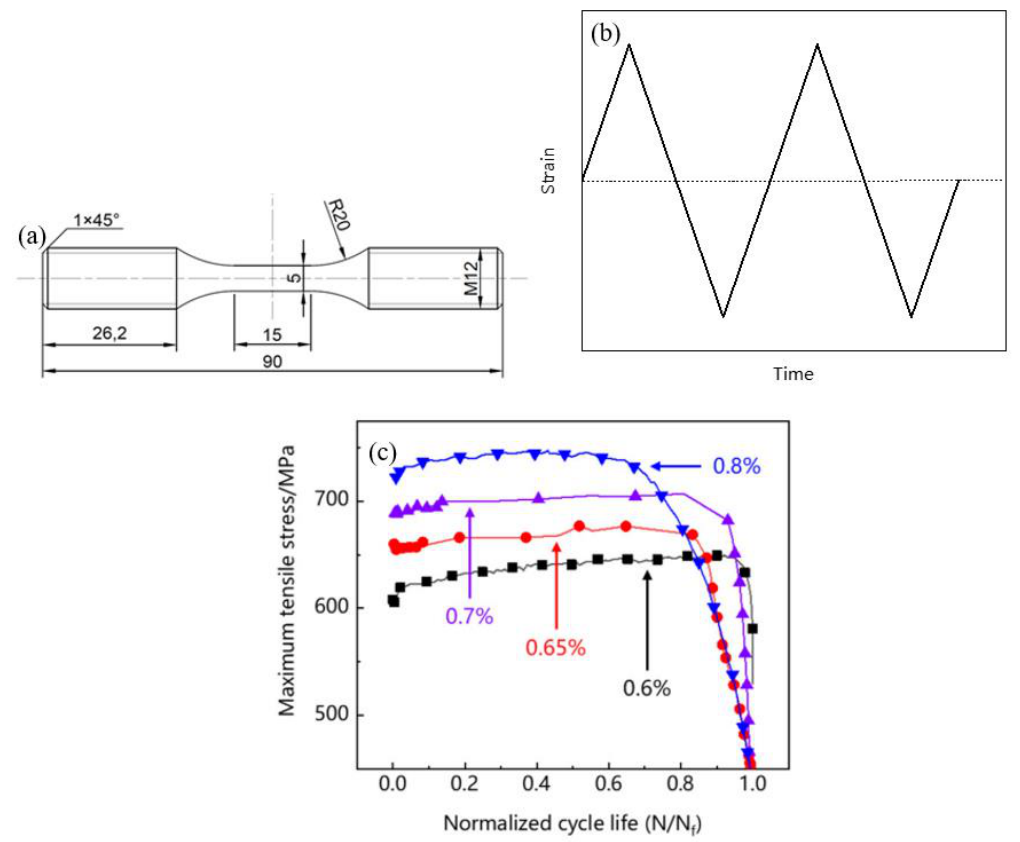
Figure 2. Microstructure characterization and element proportion of Ti2AlNb—base alloy: ( a ) grain morphology under OM (200×); and ( b ) phase composition under EBSD ( β is β phase, Ti 2 AlNb is O phase, Ti 3 Al is α 2 phase).